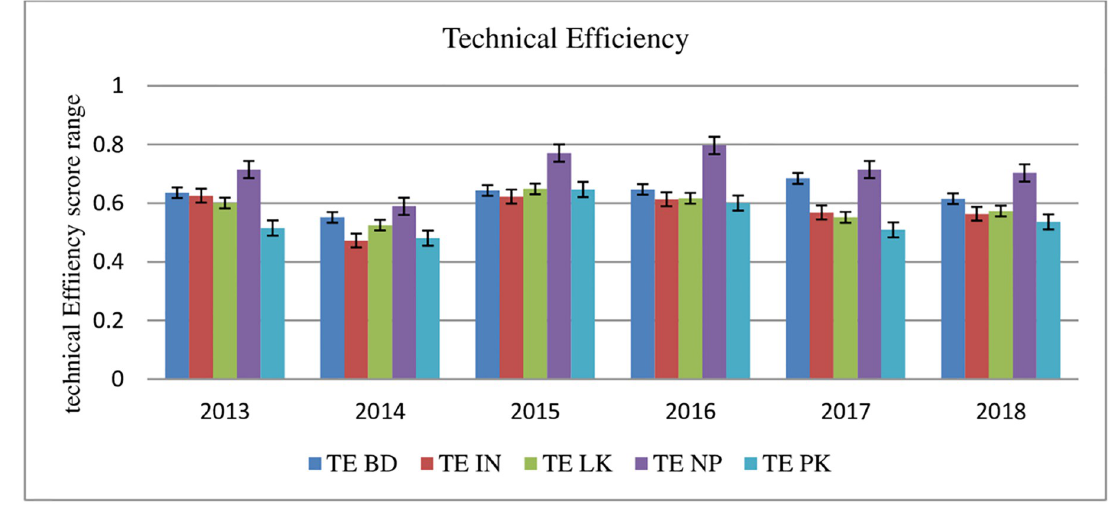
Fig 4. Technical Efficiency of CBs across the South Asian countries over time.